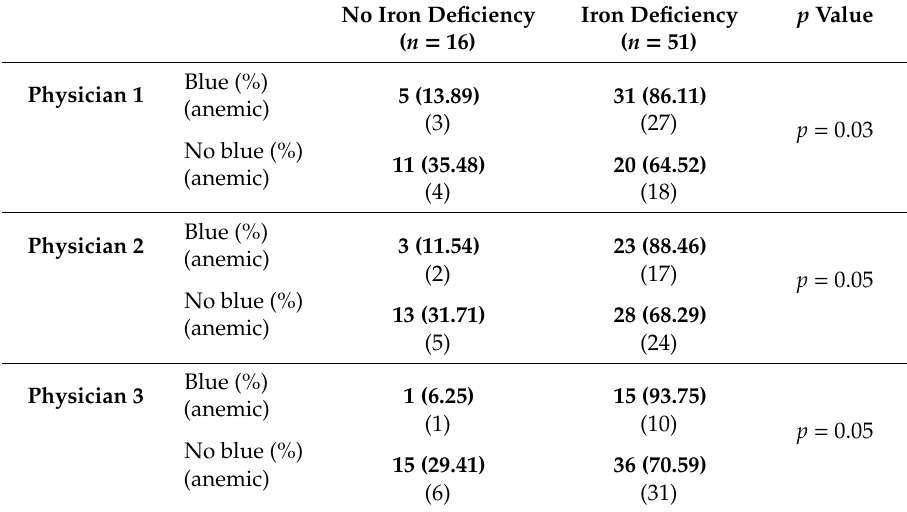
Table 1. Physician assessment of blue sclera and iron